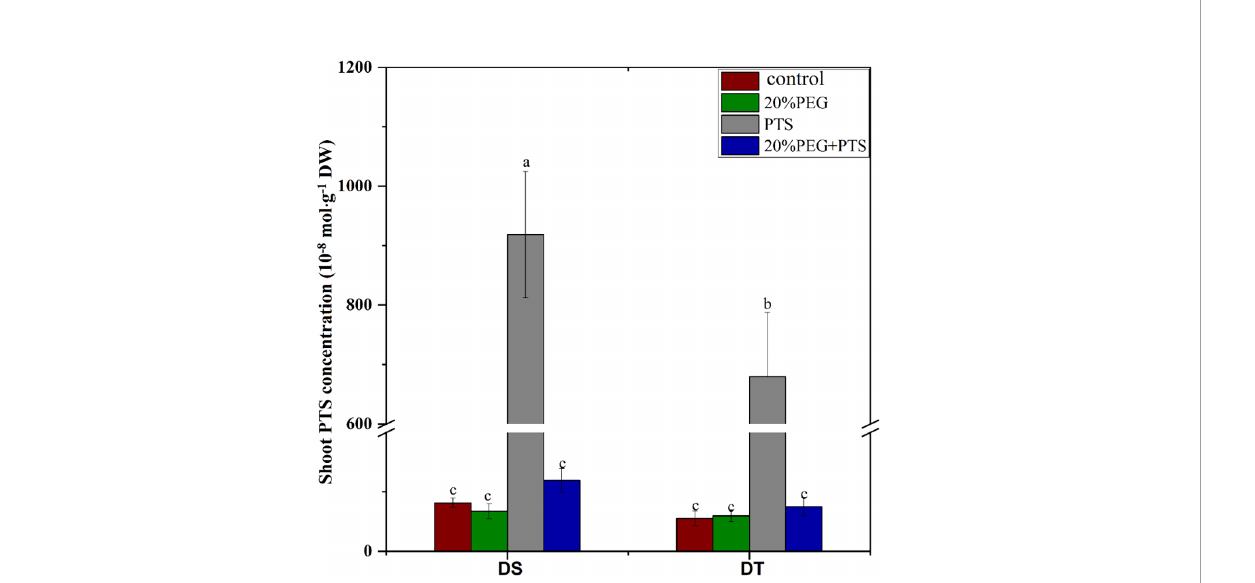
FIGURE 1 Trisodium-8-hydroxy-1,3,6-pyrenetrisulfonic acid (PTS) concentration in shoots of drought-tolerant (DT) and drought-sensitive (DS) genotypes grown under control or osmotic stress conditions. Plants were treated with 0.2 mM PTS or 0.2 mM PTS plus 20% (w/v) PEG 6000 for 72 h. Treatment without PTS was used as the negative control. Values are the mean ± standard deviation (SD) (n = 5). Different letters indicate signi fi cant differences at P < 0.05 based on one-way analysis of variance (ANOVA) (Fisher ’ s Duncan test). DW, dry